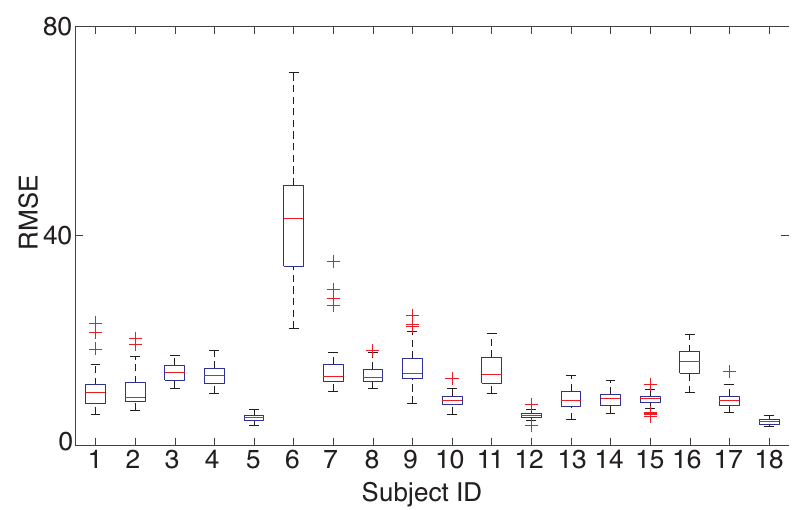
Figure 9. RMSE of RRI interpolation in each subject by LWPLS when α = 0.5%. Although RMSEs of almost all subjects except Subject 6 were less than twenty, that of Subject 6 was more than